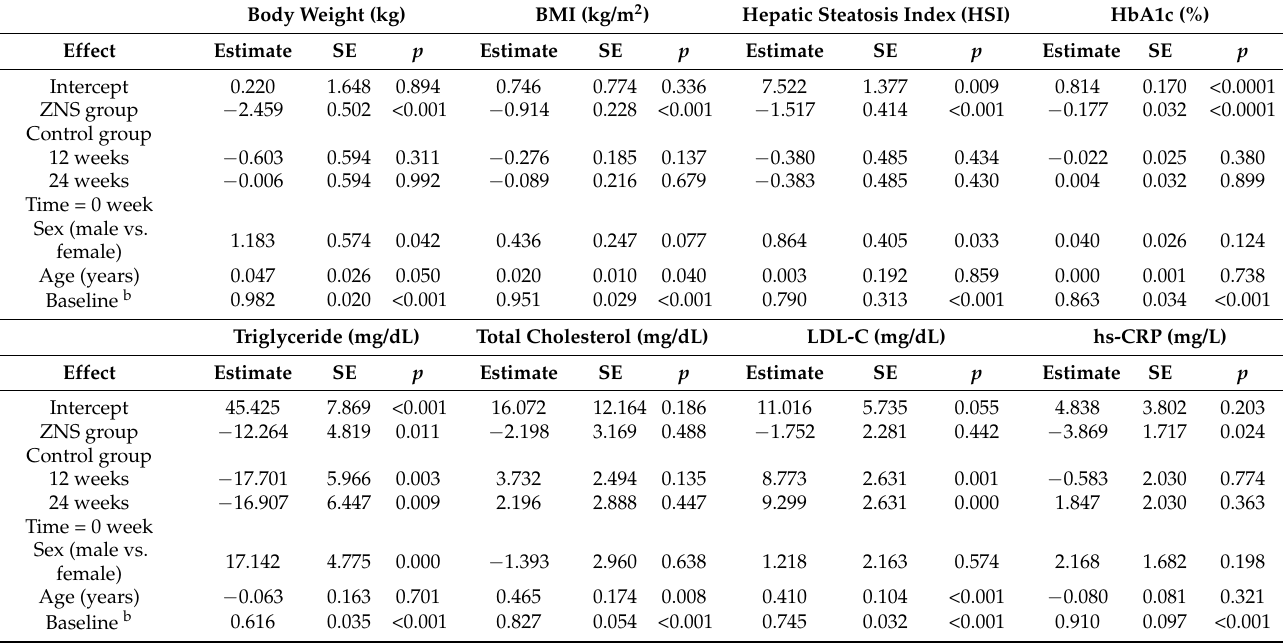
Table 3. Generalized estimating equation for dependent variables in the zonisamide-treated and control groups a .